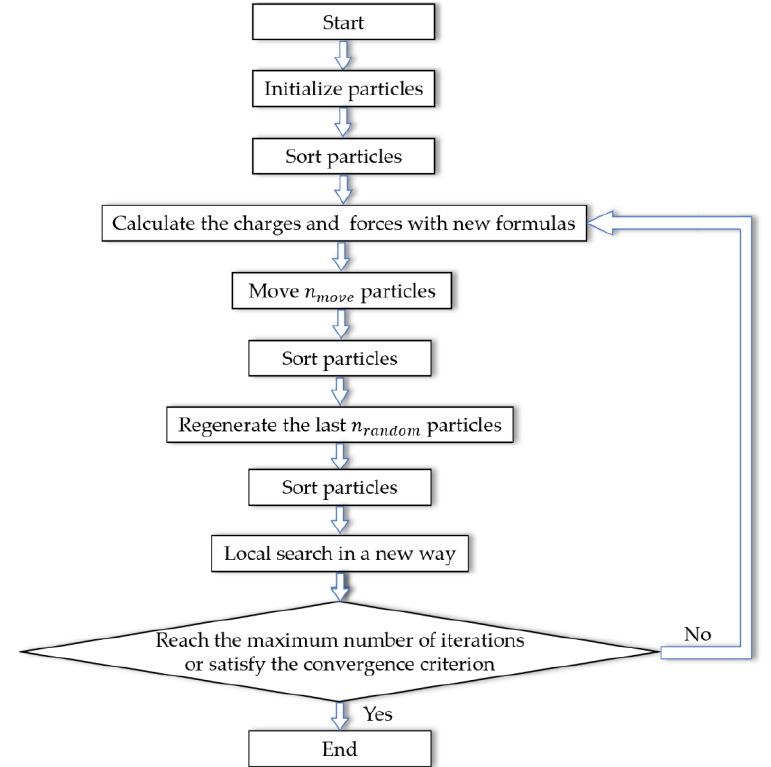
Figure 6. Flow chart of the modified EM algorithm.